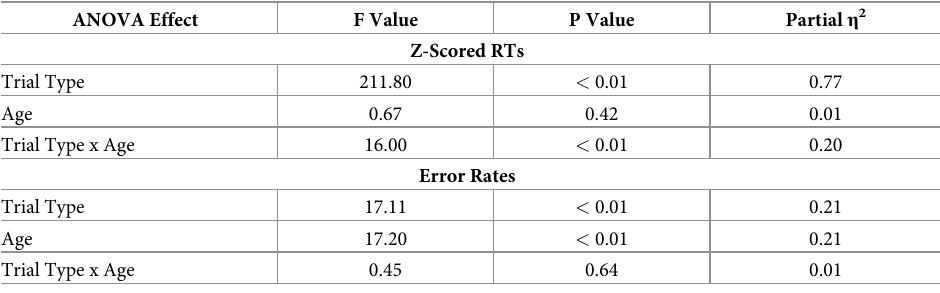
Table 2. Baseline inferential statistics for response latency and accuracy.